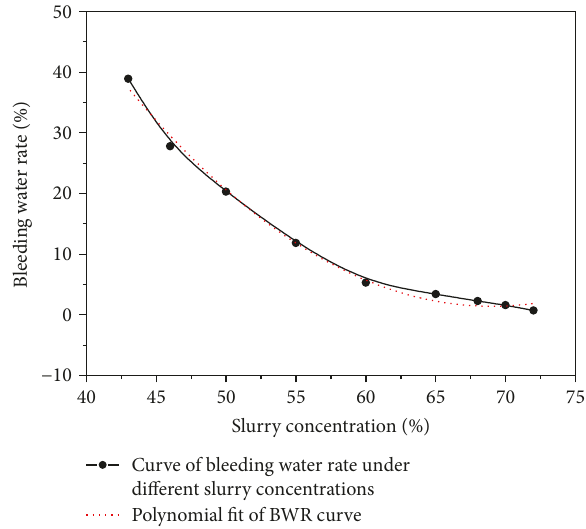
Figure 8: Relation curve of the BR and PGBS